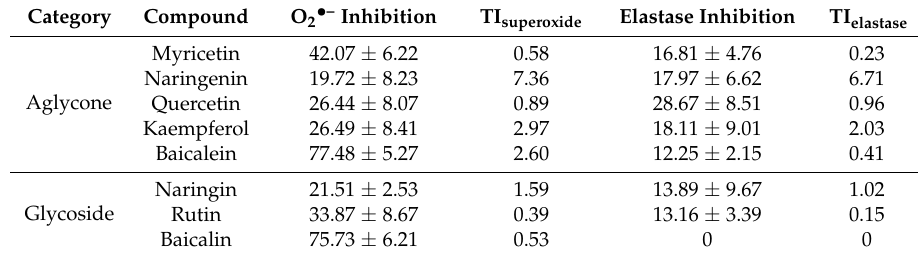
Table 2. The inhibition percentage (%) of superoxide anion (O 2 • – ) and elastase and the therapeutic index (TI) of aglycone and glycoside flavonoids at 3 µ